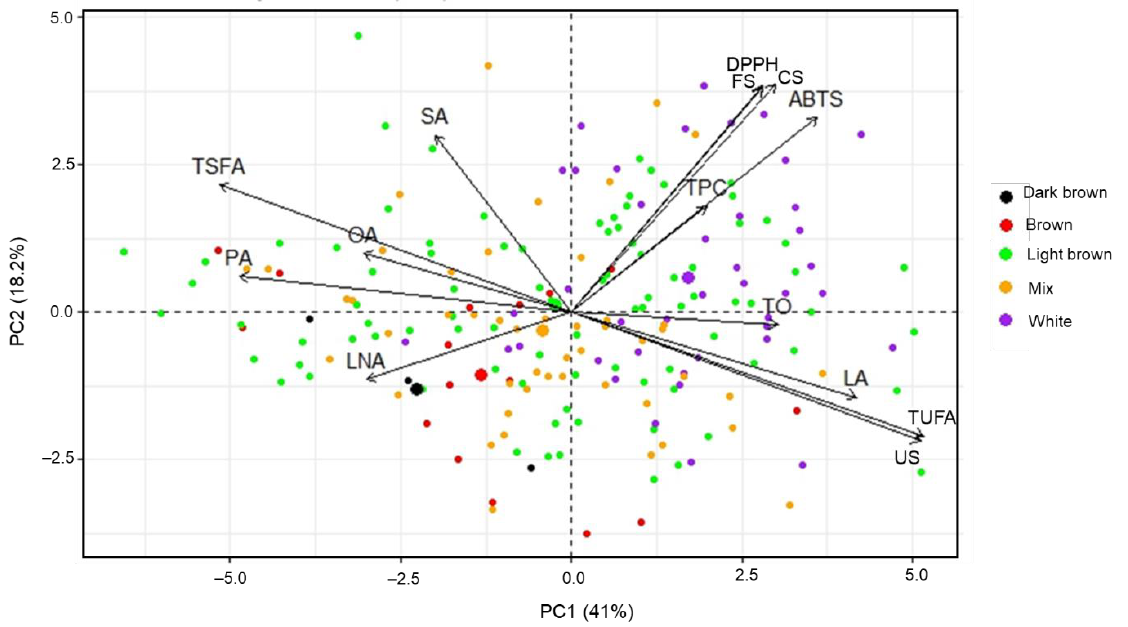
Figure 2. Principal component biplot for safflower seeds based on their total oil content, fatty acid profile, phytochemical contents, and antioxidant activities using the entire dataset. TO, total oil; PA, palmitic acid; SA, stearic acid; OA, oleic acid; LA, linoleic acid; LNA, linolenic acid; TSFA, total saturated fatty acid; TUFA, total unsaturated fatty acid; US, the ratio of TUFA to TSFA; CS, N -( p -coumaroyl)serotonin; FS, N -feruloylserotonin; TPC, total phenolic content; ABTS, ABTS radical scavenging activity; DPPH, DPPH radical scavenging activity.